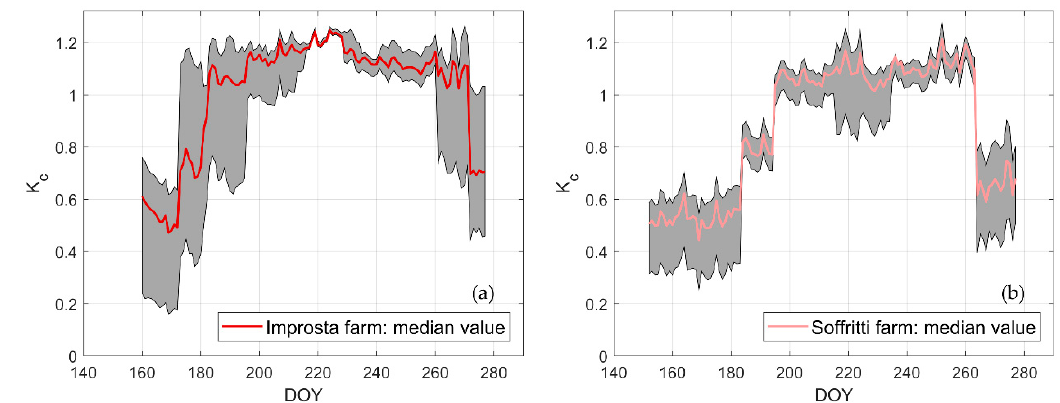
Figure 7. Temporal pattern of K c at ( a ) Improsta and ( b ) Soffritti farms. The gray band reflects the effect of LAI variability at each farm.